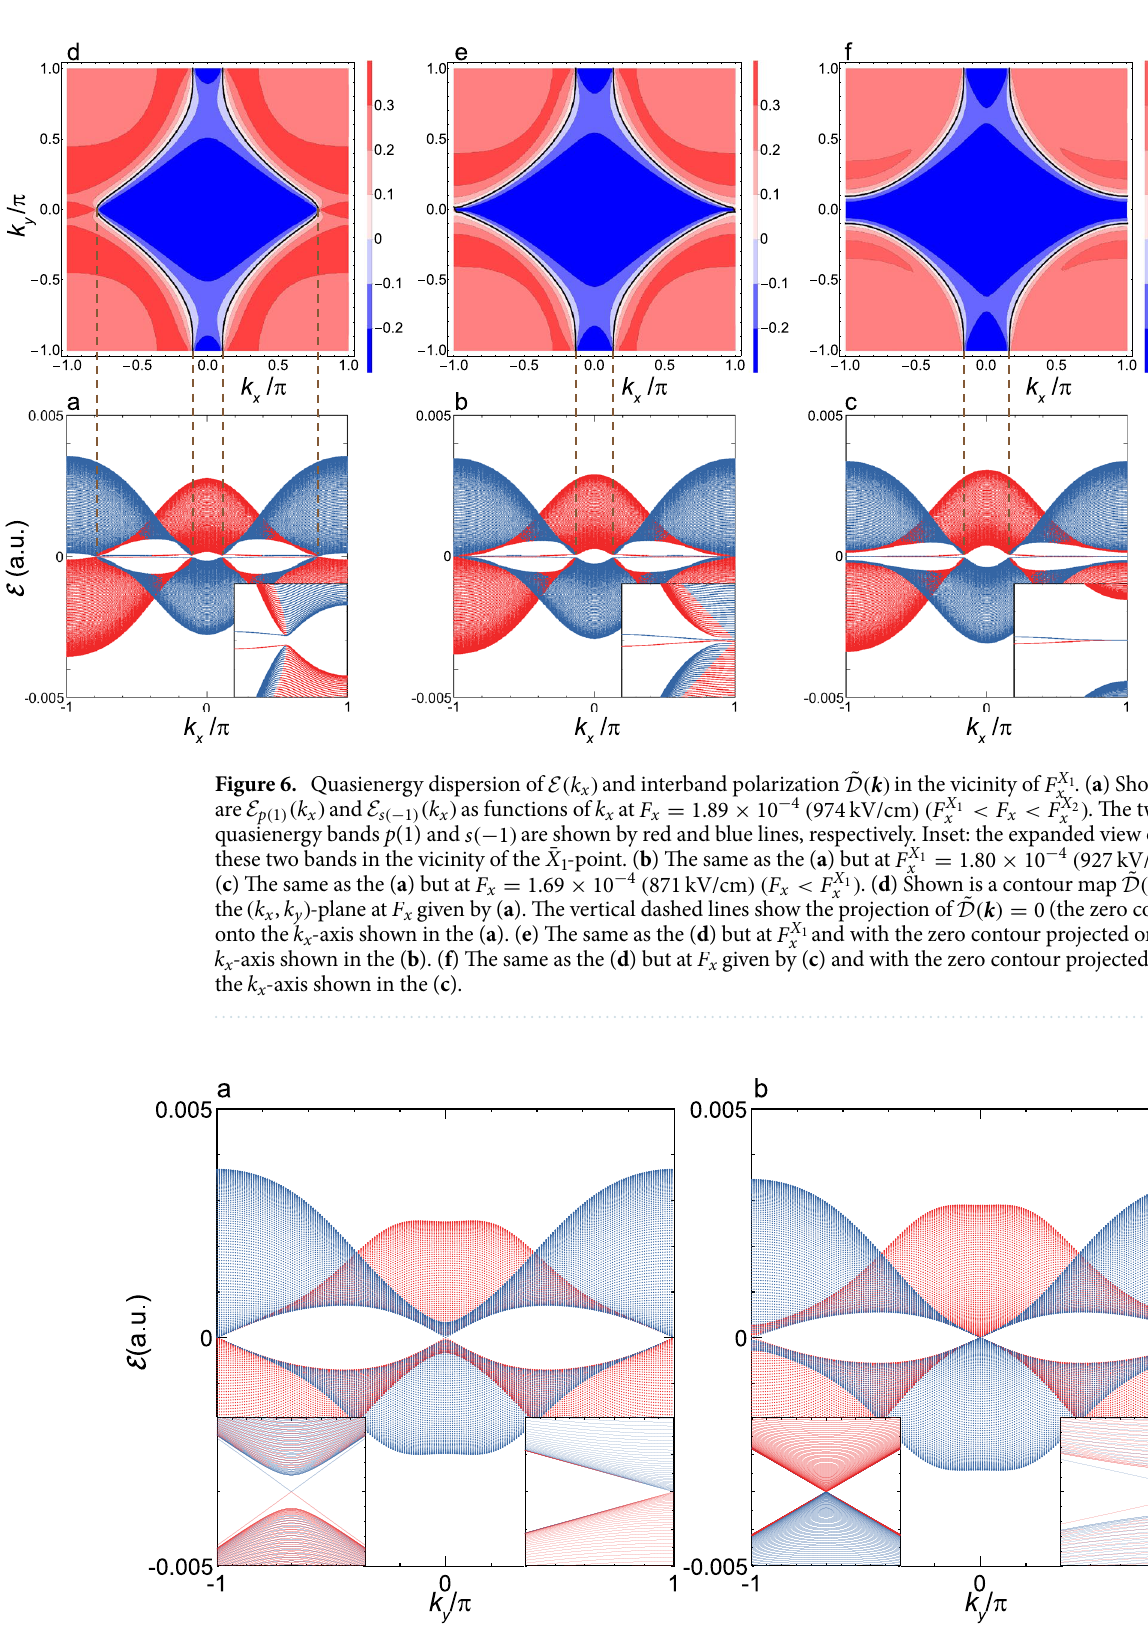
Figure 7. Quasienergy dispersion of E ( k y ) at F X 2 x and F X 1 x . ( a ) Shown are E p ( 1 ) ( k y ) and E s ( − 1 ) ( k y ) as functions of = 2.04 × 10 − 4 ( 1.05MV/cm ) . The two quasienergy bands p (1) and s ( − 1 ) are shown by red and blue k y at F X 2 x lines, respectively. Insets: the expanded view of these two bands in the vicinity of the ¯ Ŵ ′ ( ¯ X ′ 1 ) -point (left) and the ¯ X ′ X 1 = 1.80 × 10 − 4 ( 927 kV/cm ) 2 -point (right). ( b ) The same as the ( a ) but at F x